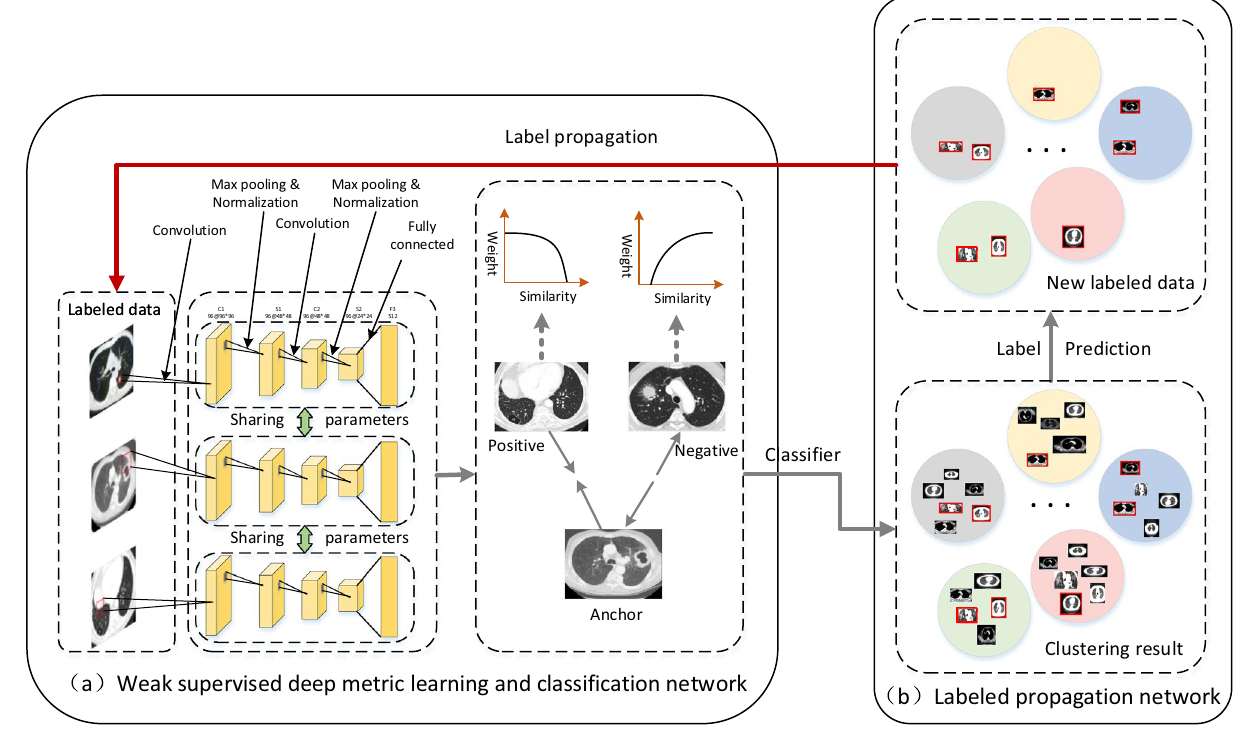
Figure 5. The framework of the proposed WS-DMGC. The framework consists of two subnetworks: ( a ) a feature extraction sub-network by Triplet CNNs; ( b ) a label propagation sub-network by graph clustering algorithm, circles in different colors indicate the clustering results for each